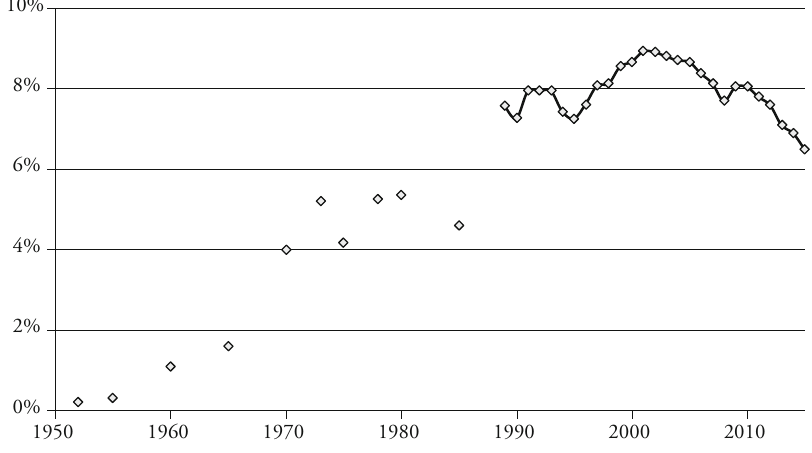
Figure 2: Shadow Economy Estimates for Switzerland over Time (% of